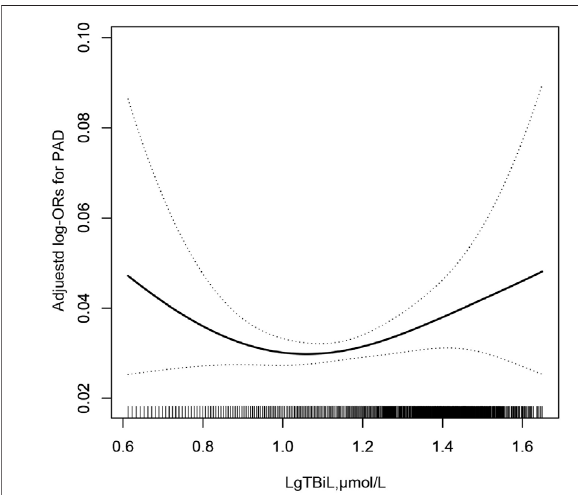
FIGURE 2 | Association between LgTBil and the prevalence of PAD by sex. A nonlinear association between TBil and the prevalence of PAD by sex was found ( p < 0.05). The solid line and dashed line represent the estimated values in male and female, respectively. The adjustment factors included age, BMI, SBP, DBP; smoking status, drinking status, diabetes mellitus, stroke,CHD,Hcy,FPG,TG,LDL-C,AST,ALT,eGFR,antihypertensivedrugs, glucose-lowering drugs, lipid-lowering